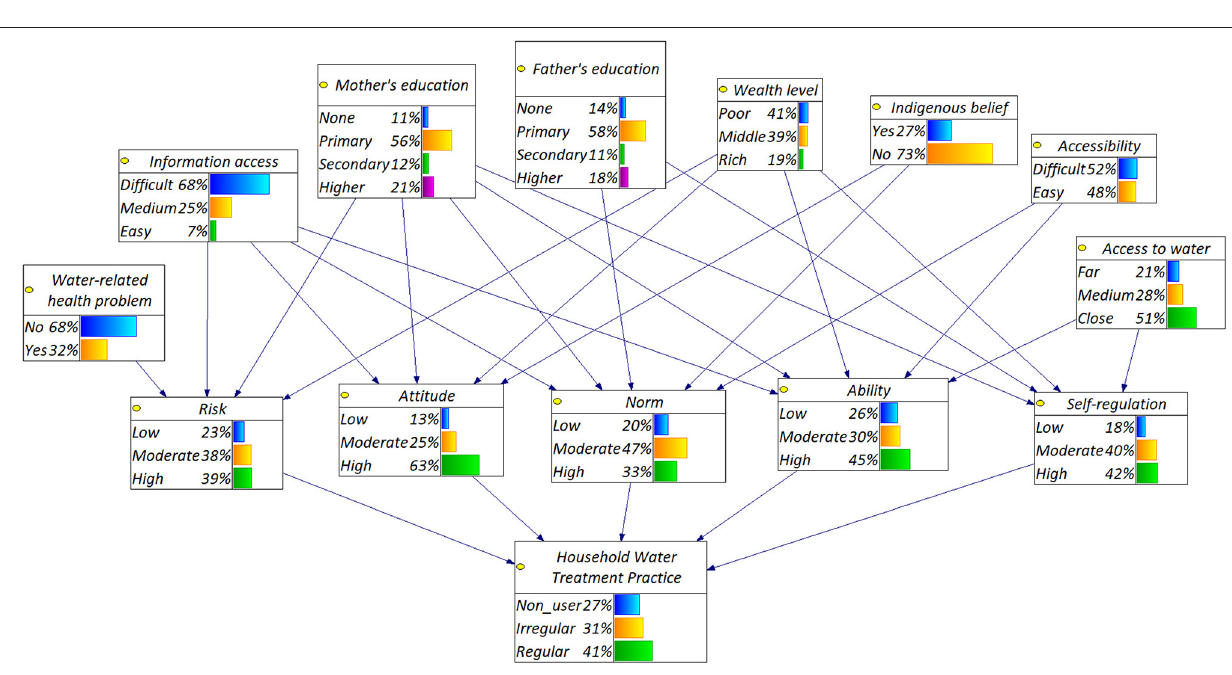
FIGURE 5 | The BBN model showing the hypothetical causal relationship between socio-economic characteristics (SECs), RANAS psychological factors, and HWT practice in rural Indonesia. The bars in each node show the probability that a node is in a certain state (status quo or existing